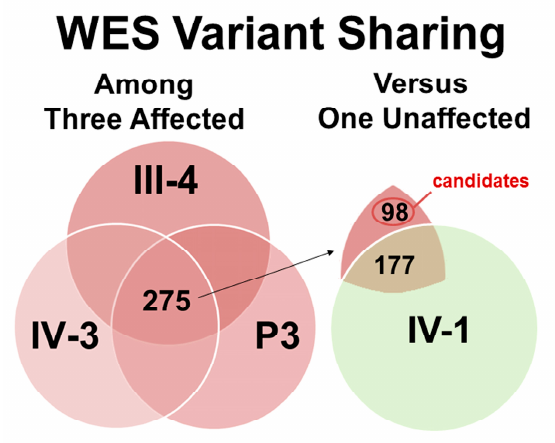
Figure 5. Whole Exome Sequencing (WES) Studies and Variant Sharing of Four Family Members to Identify Candidate Variants in DD and LD. Diagram provided to represent the total number of potentially deleterious variants found in the three affected individuals: 1,677 variants for III-4, 1,681 variants for IV-3, and 1,815 variants for Patient 3 (red circles) and the one unaffected individual: 1,761 variants for IV-1 (green circle). For the affected individuals, the central overlapping region represents the shared variants ( n = 275). When compared to the variants of the unaffected individual, 177 shared variants (overlapping region) were excluded and 98 unshared variants (non-overlapping region) were identified as candidates in DD and LD.